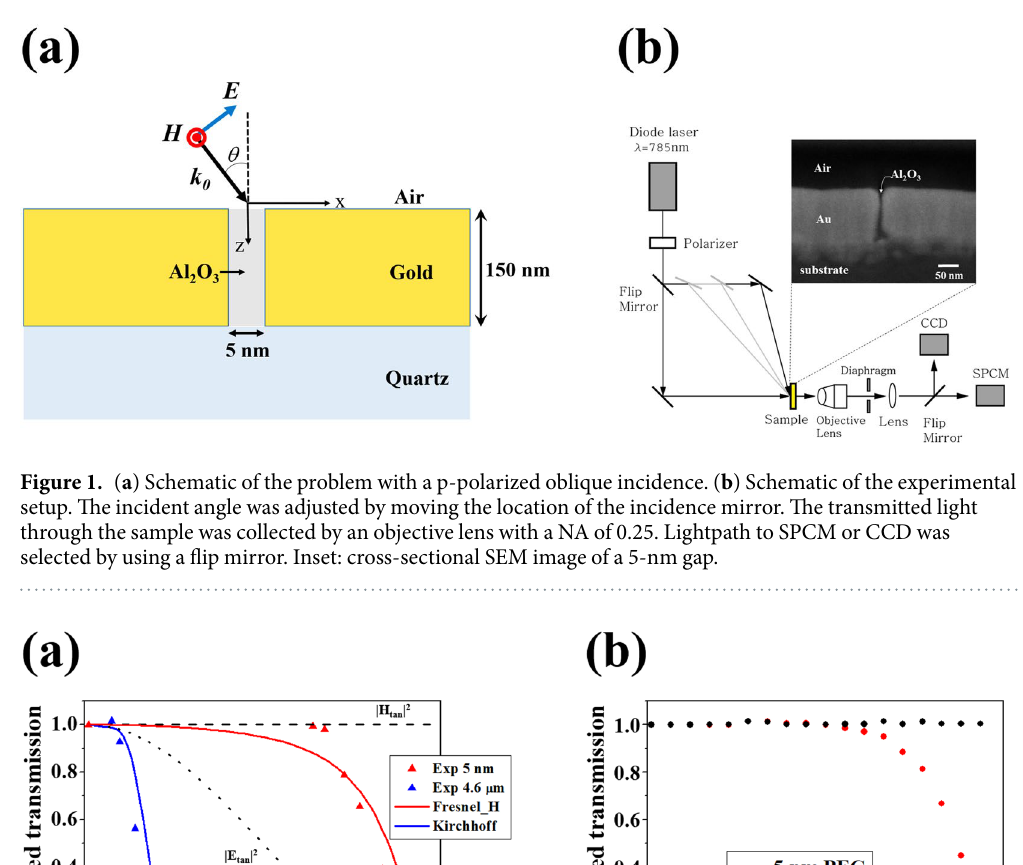
setup. By changing the incidence mirror location, a 785-nm laser beam was obliquely incident on the sample with various incident angles. The transmitted light through the sample was collected in the normal direction by an objec- tive lens whose numerical aperture (NA) is 0.25. A single photon counting module (SPCM) was used for the signal detection. Identifying the gap locations by using a CCD camera, we averaged the signals from three different loca- tions at least. We normalized the oblique incident transmission intensities by the normal incident transmission intensity. We fabricated a uniform 5-nm slit on a 150-nm-thick gold film using atomic layer lithography previously reported by Chen and Park et al . 10 . Details of the nanogap fabrication are covered in the Methods section. For comparison with the 5-nm slit, a 4.6- μ m slit was perforated on a gold film with the same thickness by focused ion beam milling. Dependence of the 5-nm-gap transmission on the incident magnetic and electric fields can be examined from the dependence on the incident angle. Because the incident light is p-polarized, the vertical and tangential components of the incident electric field vary as sine and cosine functions of the incident angle. Meanwhile, the incident magnetic field has only the tangential component that is constant over all incident angles (Fig. 1(a)). According to Babinet’s principle, a slit on a thin PEC film acts as a 2-dimensional magnetic dipole directed along the slit and radiates in proportion to the incident tangential magnetic field. If also the radiation of the 5-nm slit is determined by the incident tangential magnetic field, the transmission would be constant over all inci- dent angles (Fig. 2(a), black dashed line). On the contrary, if the incident tangential electric field determines the